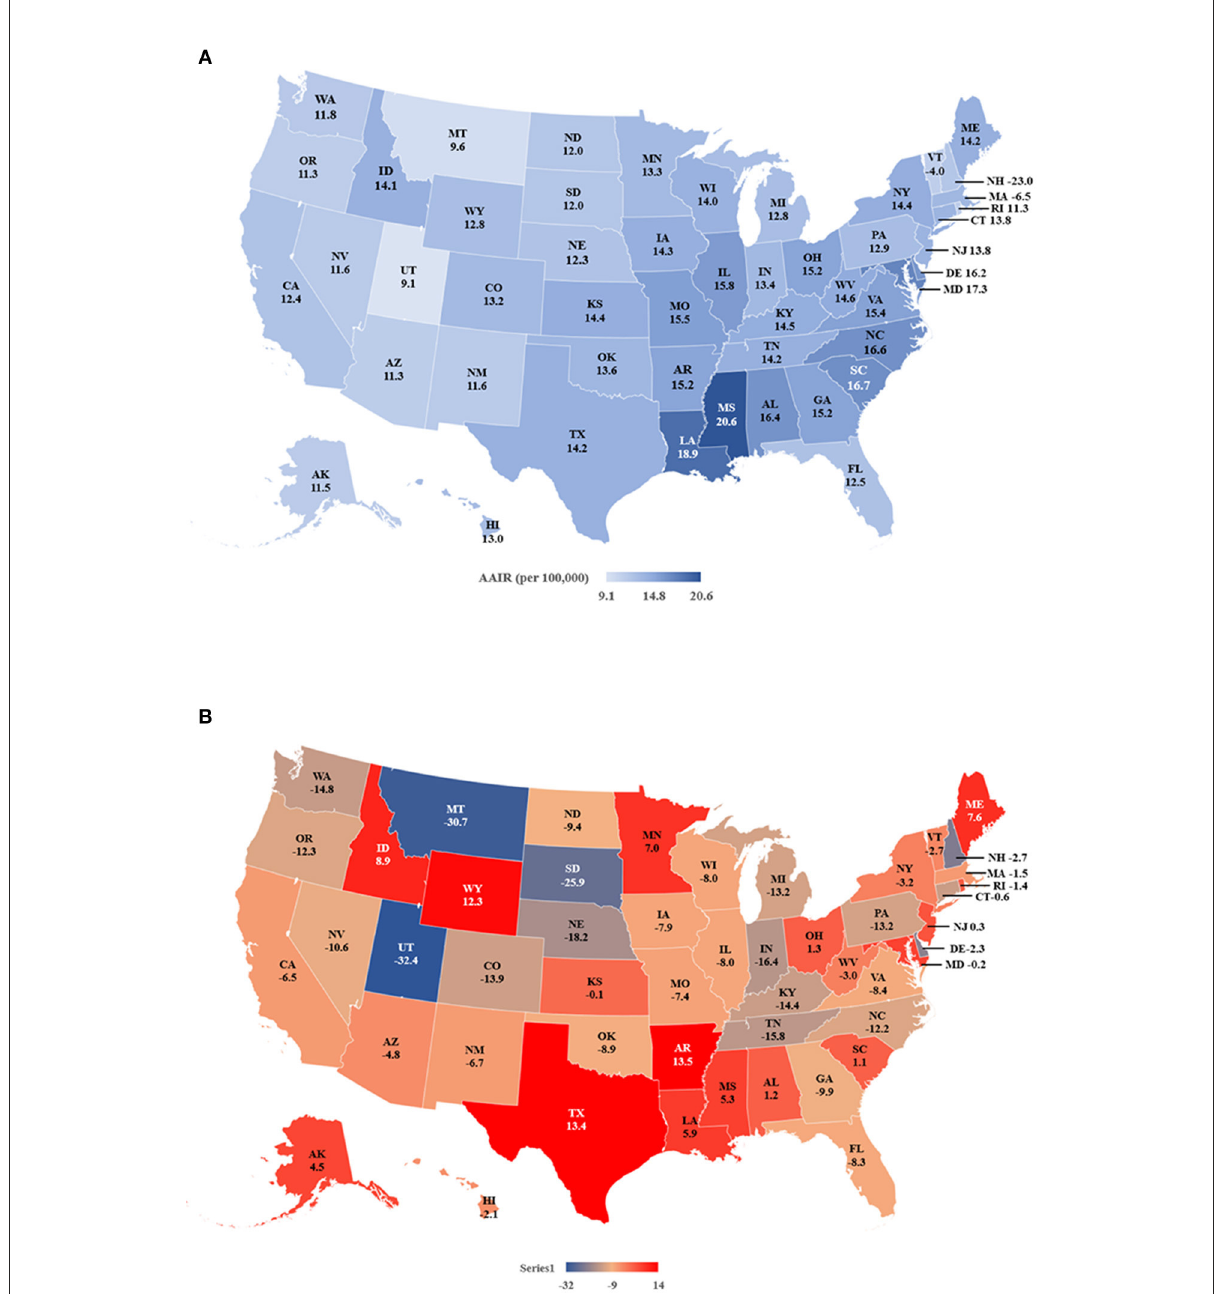
FIGURE3 Age adjusted incidence rates (AAIR) of TNBC in individual states during 2011–2019. (A) AAIR of TNBC in 2019. (B) Percentage of change in AAIR in individual states from 2011 to 2019. Please note that there is no incidence rate of TNBC of NV in 2018 and 2019. The incidence rate of NV in 2017 is shown on the